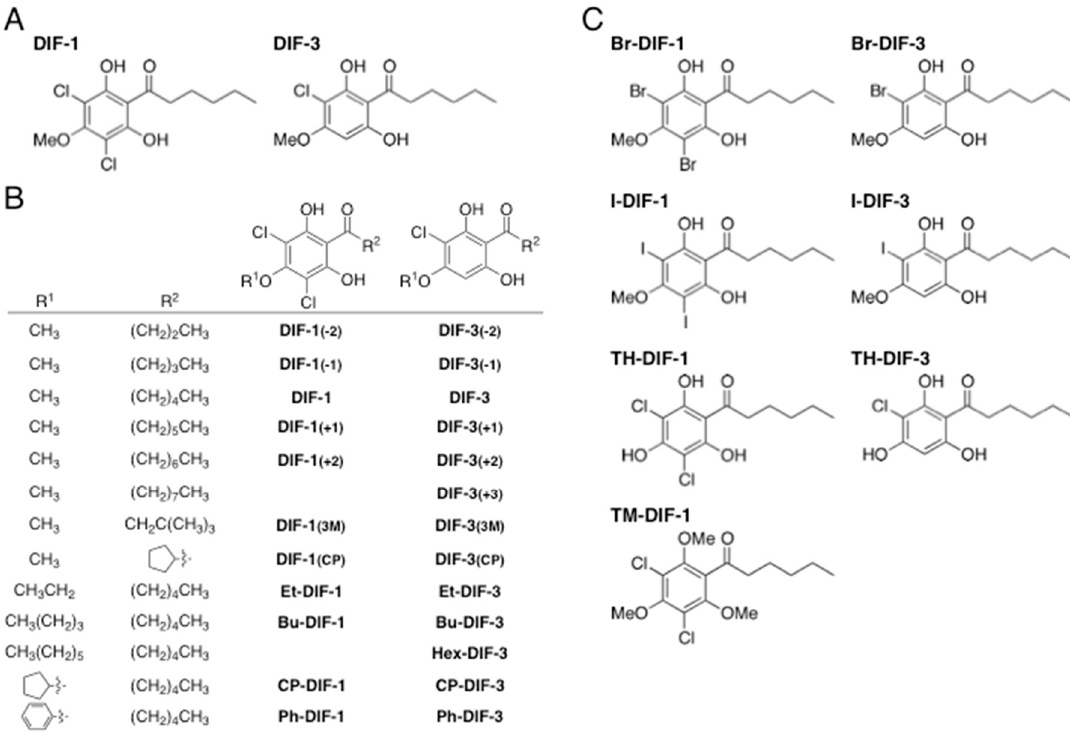
Figure 1. ( A ) Chemical structures of Dictyostelium discoideum differentiation-inducing factor (DIF) 1 and DIF-3. ( B , C ) Chemical structures of DIF derivatives used in this study.